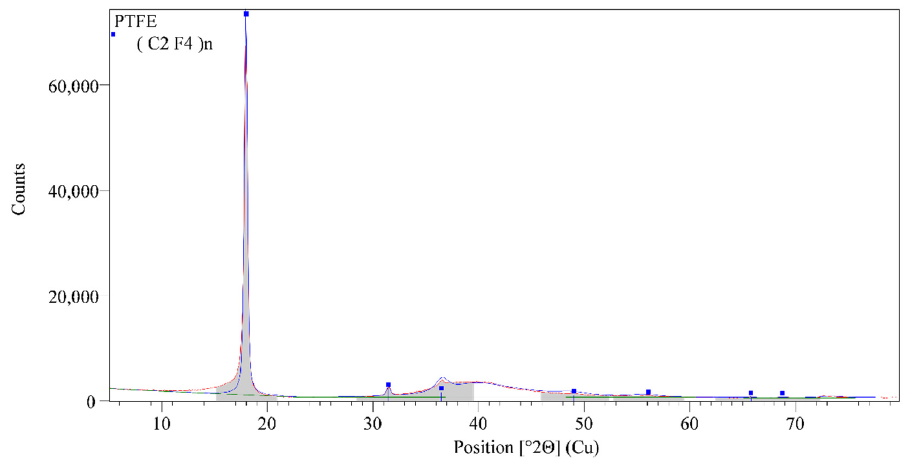
Figure 7. XRD pattern of polytetrafluoroethylene (PTFE).